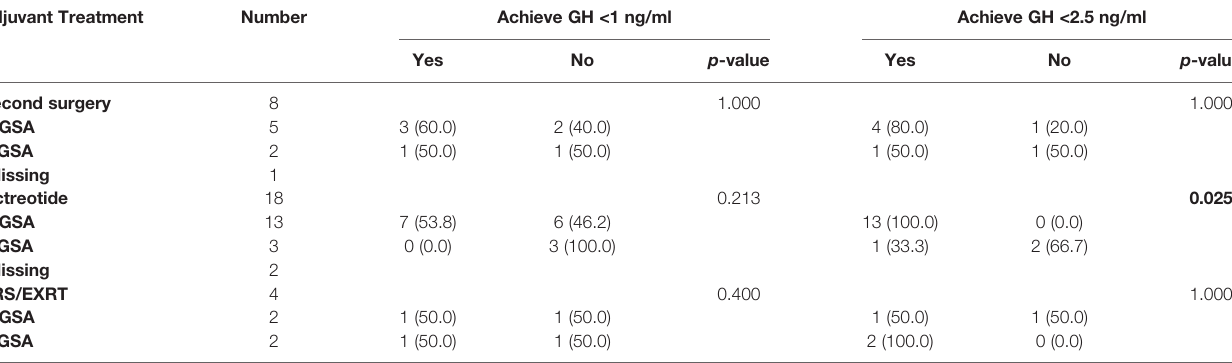
TABLE 6 | The association between histology subtypes and remission in different treatment for patients with failed fi rst TSA operation ( n = 41). Adjuvant